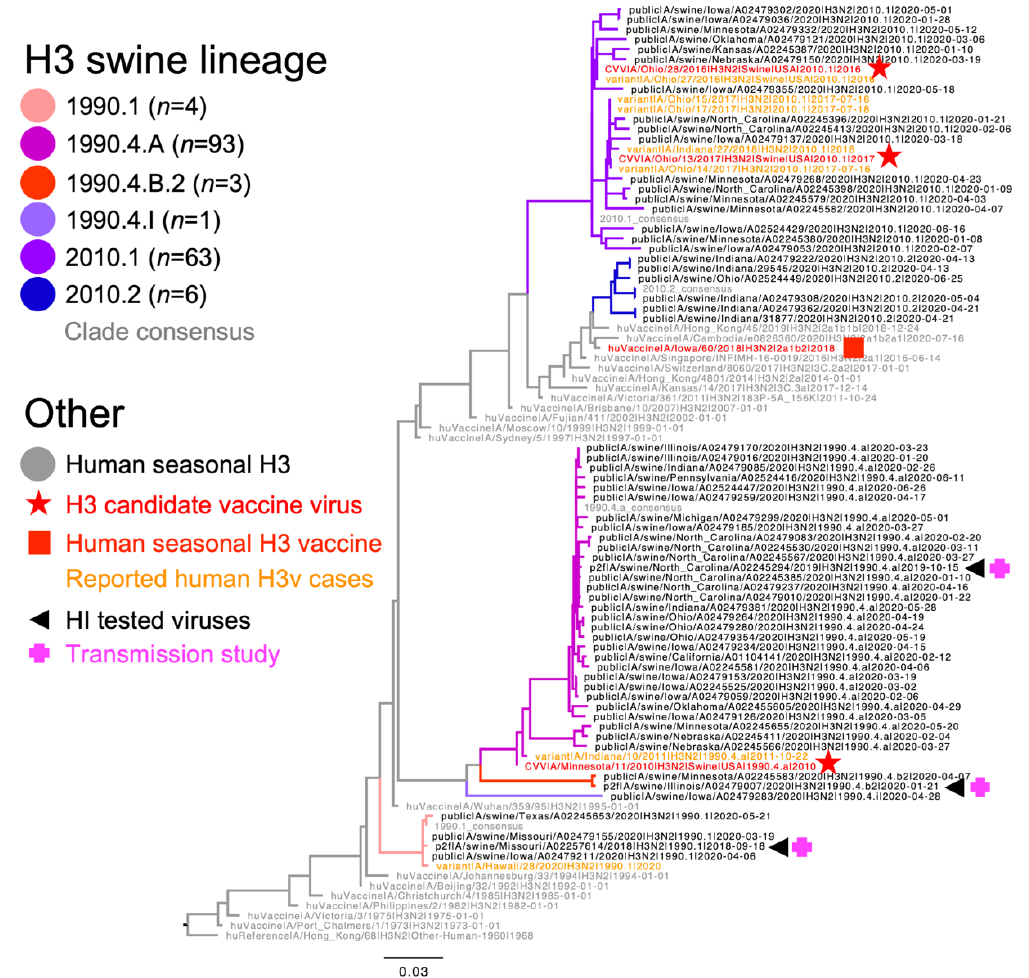
Figure 1. Evolutionary relationships of contemporary H3 swine influenza A viruses. A representative random sample of H3 swine hemagglutinin (HA) genes collected between January 2020 and June 2020. Reference human HA genes, candidate vaccine viruses (CVV), and variant cases are indicated by branch color or shape. Swine IAV strains tested in hemagglutination inhibition assays are marked by a black triangle, and those used in transmission studies by a pink plus sign (+). The numbers in parentheses indicate the number of each genetic clade detected during the sampling period.